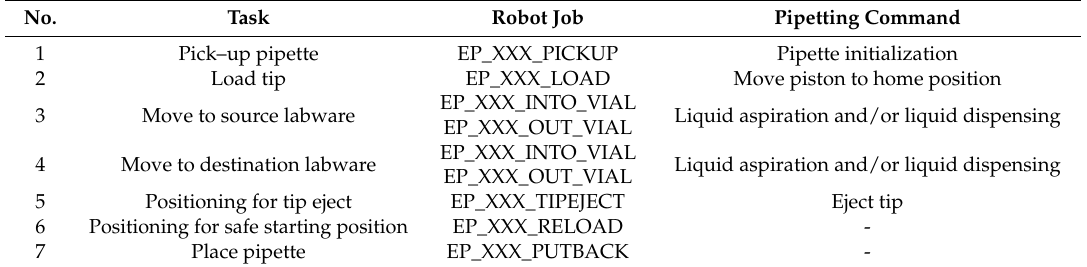
Table 5. Sequence control with robot jobs and pipetting commands (“XXX” = 200 or 1000 = pipette type).